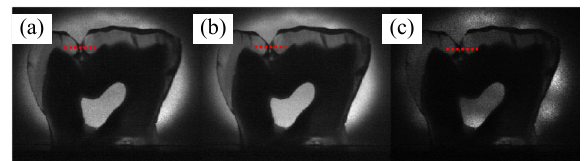
Fig. 5 Images of diseased tooth: (a) RFL image, (b) ASE image, and (c) NLL image.